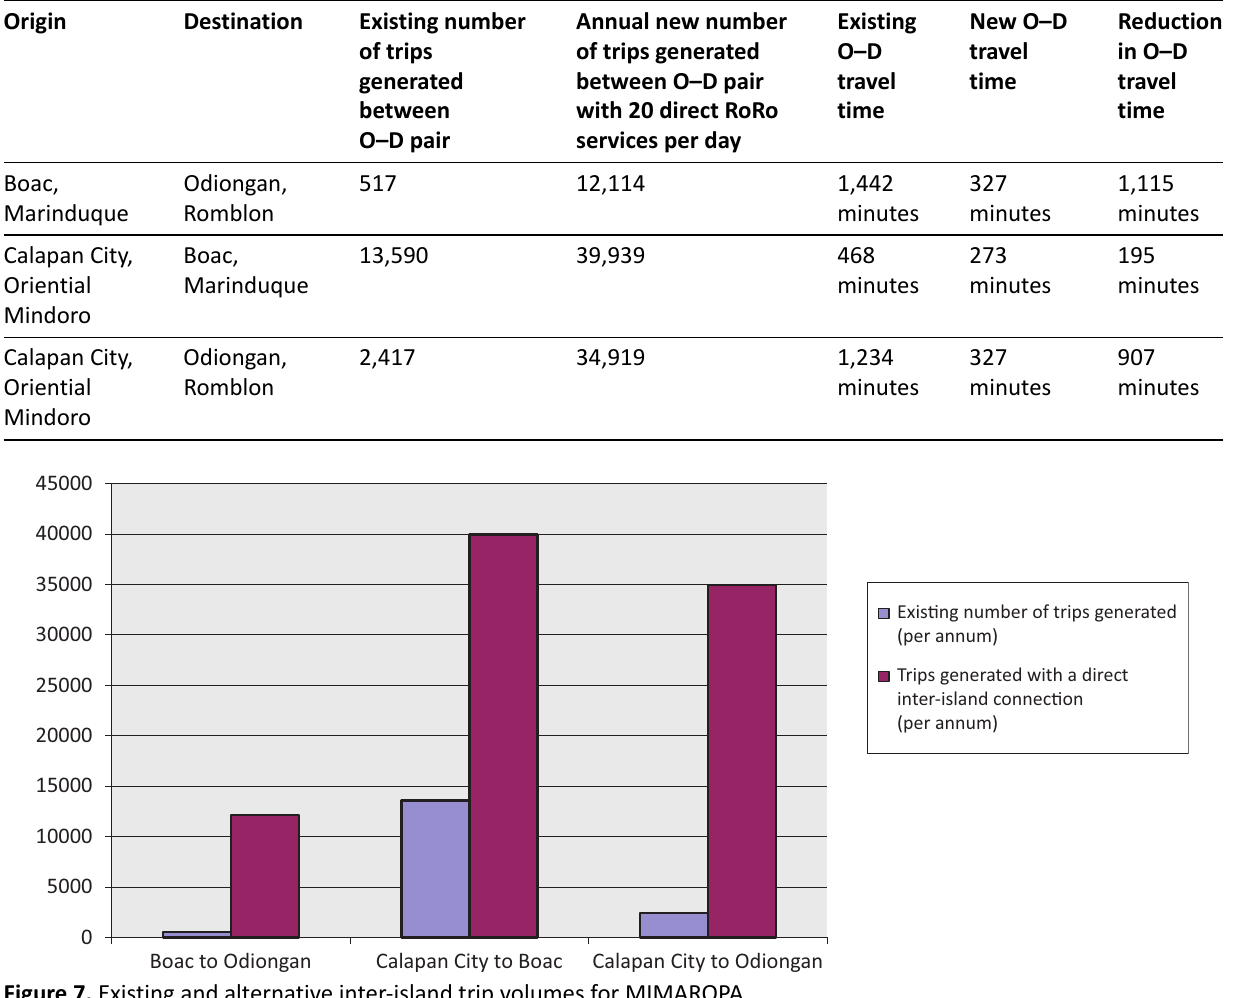
Table 4. Alternative gravity model results.